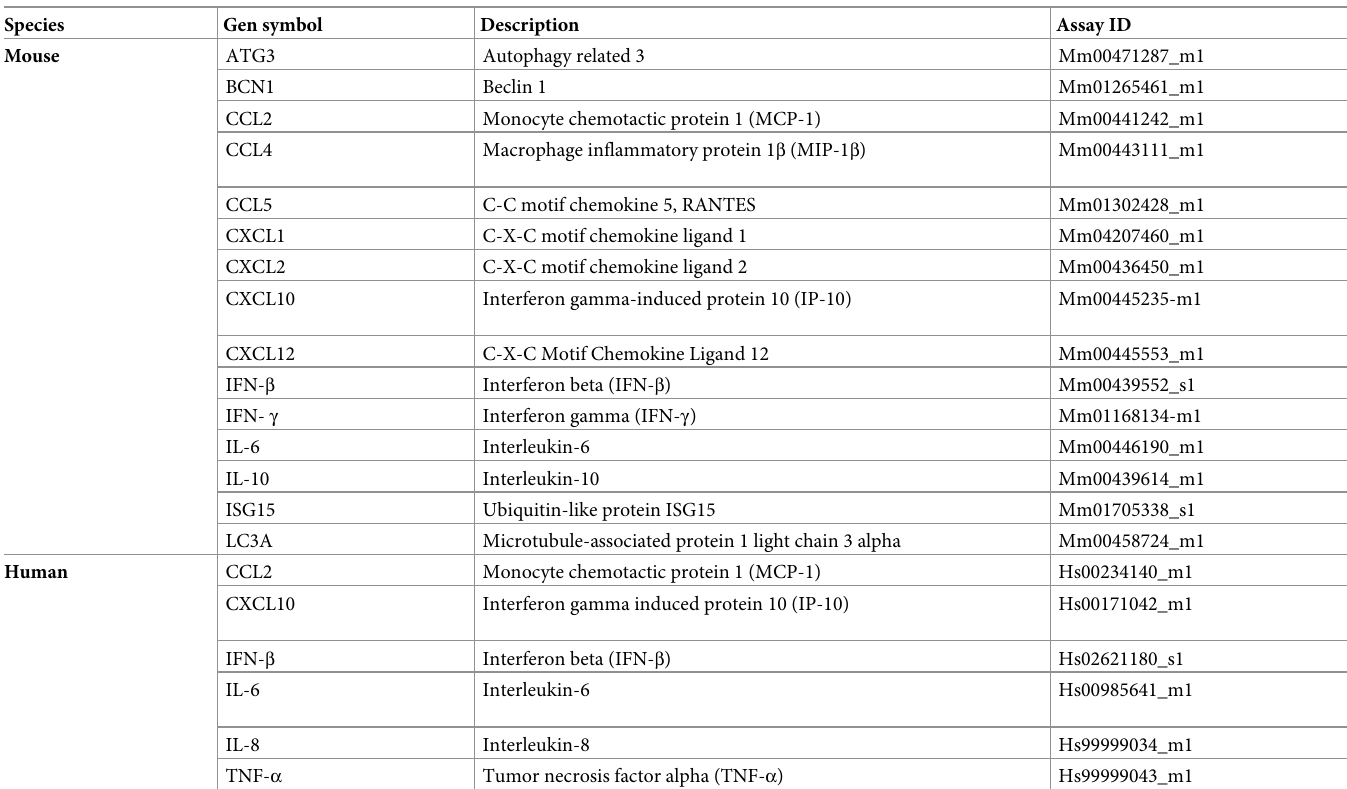
Table 1. Taqman assays.